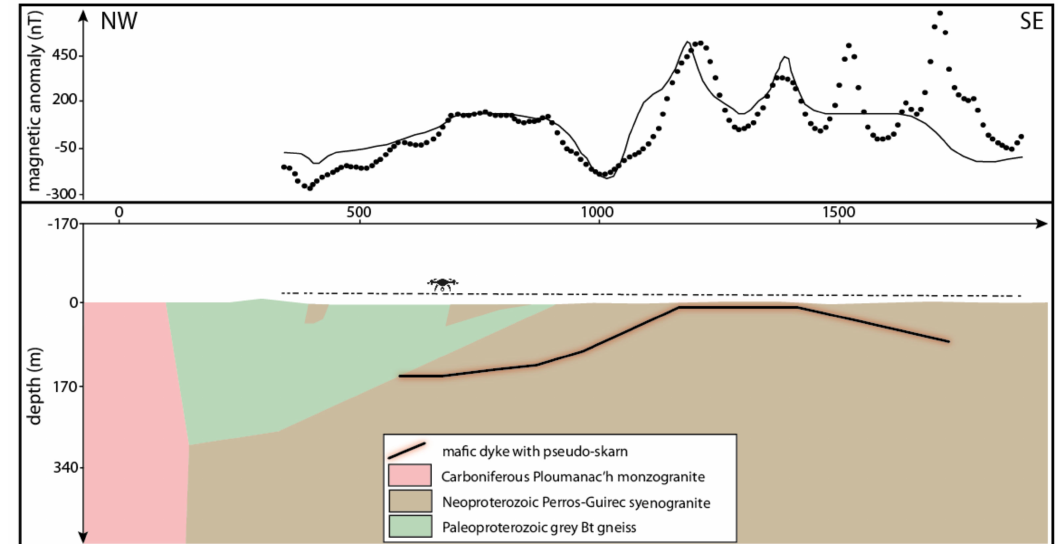
Figure 7. Regional magnetic model along the coast, confronted with the high-resolution UAV magnetic data. Upper window: UAV-borne measured magnetic anomaly (dots) compared to the computed magnetic model effect (line). Lower window: colors of modelled geological units are consistent with Figure 2. The overall fit of the profile is surprisingly good, most magnetic anomalies are fitted at the first order, except short wavelength anomalies at the southeastern end of the